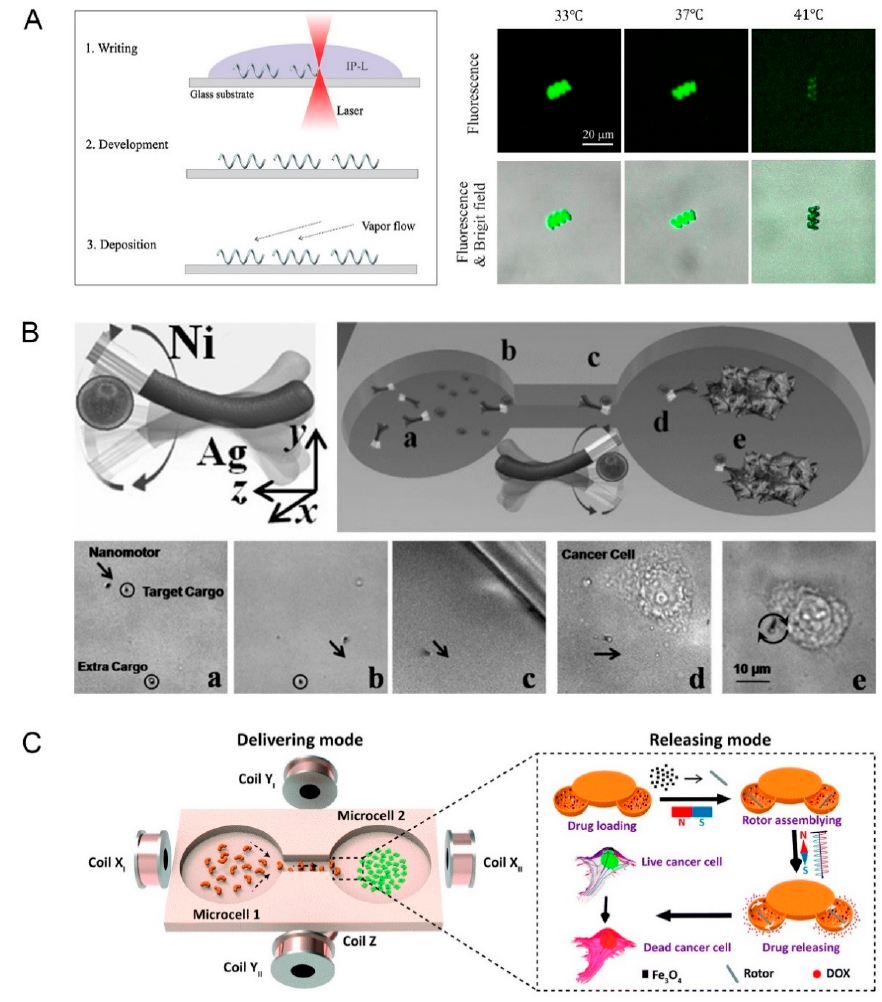
Figure 1. Propulsion mechanism and drug delivery of magnetic field propelled micro / nanorobots. ( A ) Helically-shaped microrobot with artificial bacterial flagella and drug-loaded liposomes (reprinted from [28] with permission from Elsevier, 2014); ( B ) Magnetic Ni-Ag nanorobot with flexible structure (reprinted from [35] with permission from John Wiley and Sons, 2012); ( C ) Pine pollen-based microrobot with Fe 3 O 4 magnetic particles and drugs (reprinted from [40] with permission from Royal Society of Chemistry,